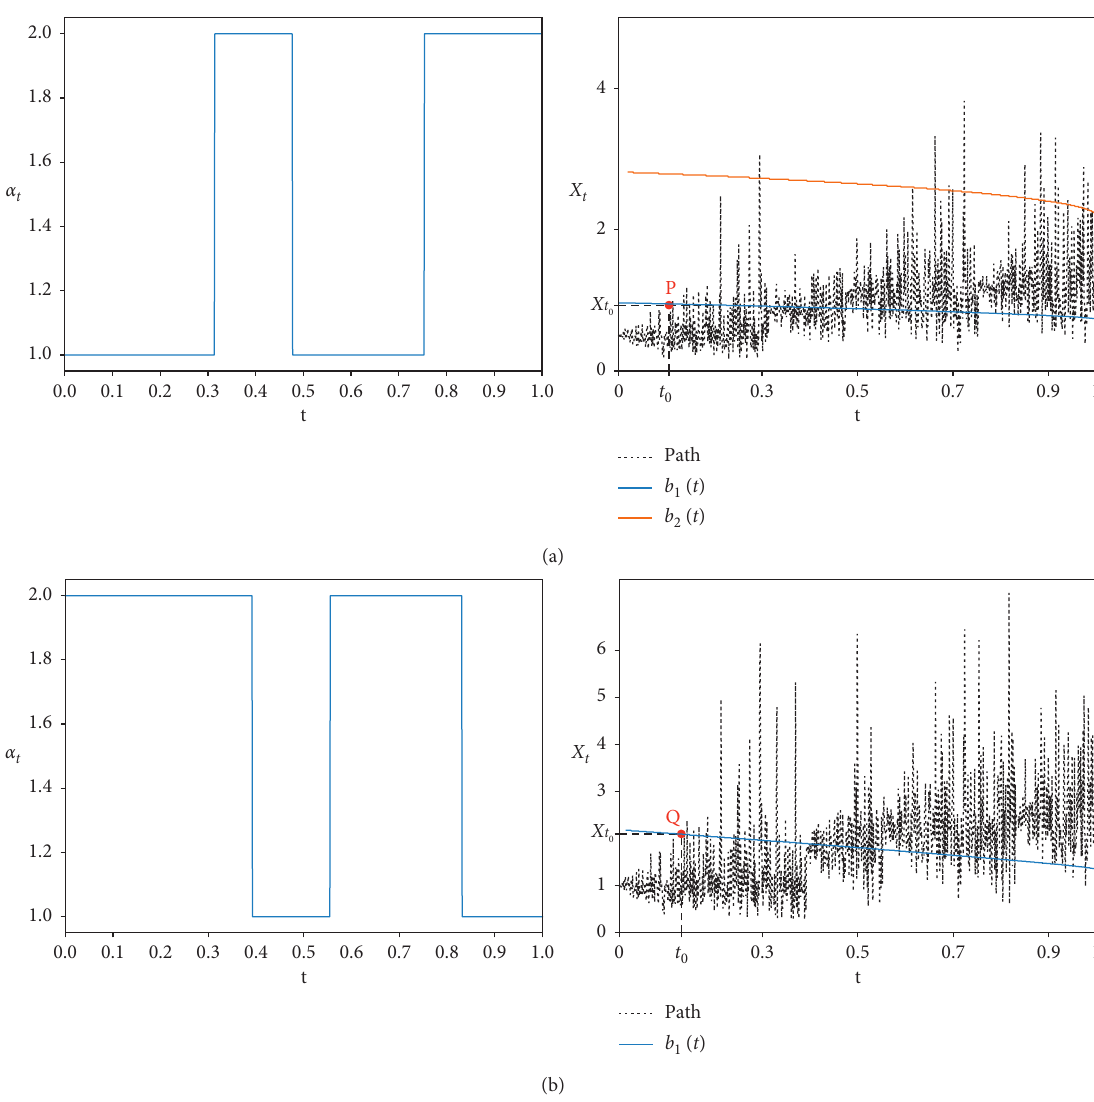
� 1, S � 0 . 5, and early exercise boundary when r > μ 0 0